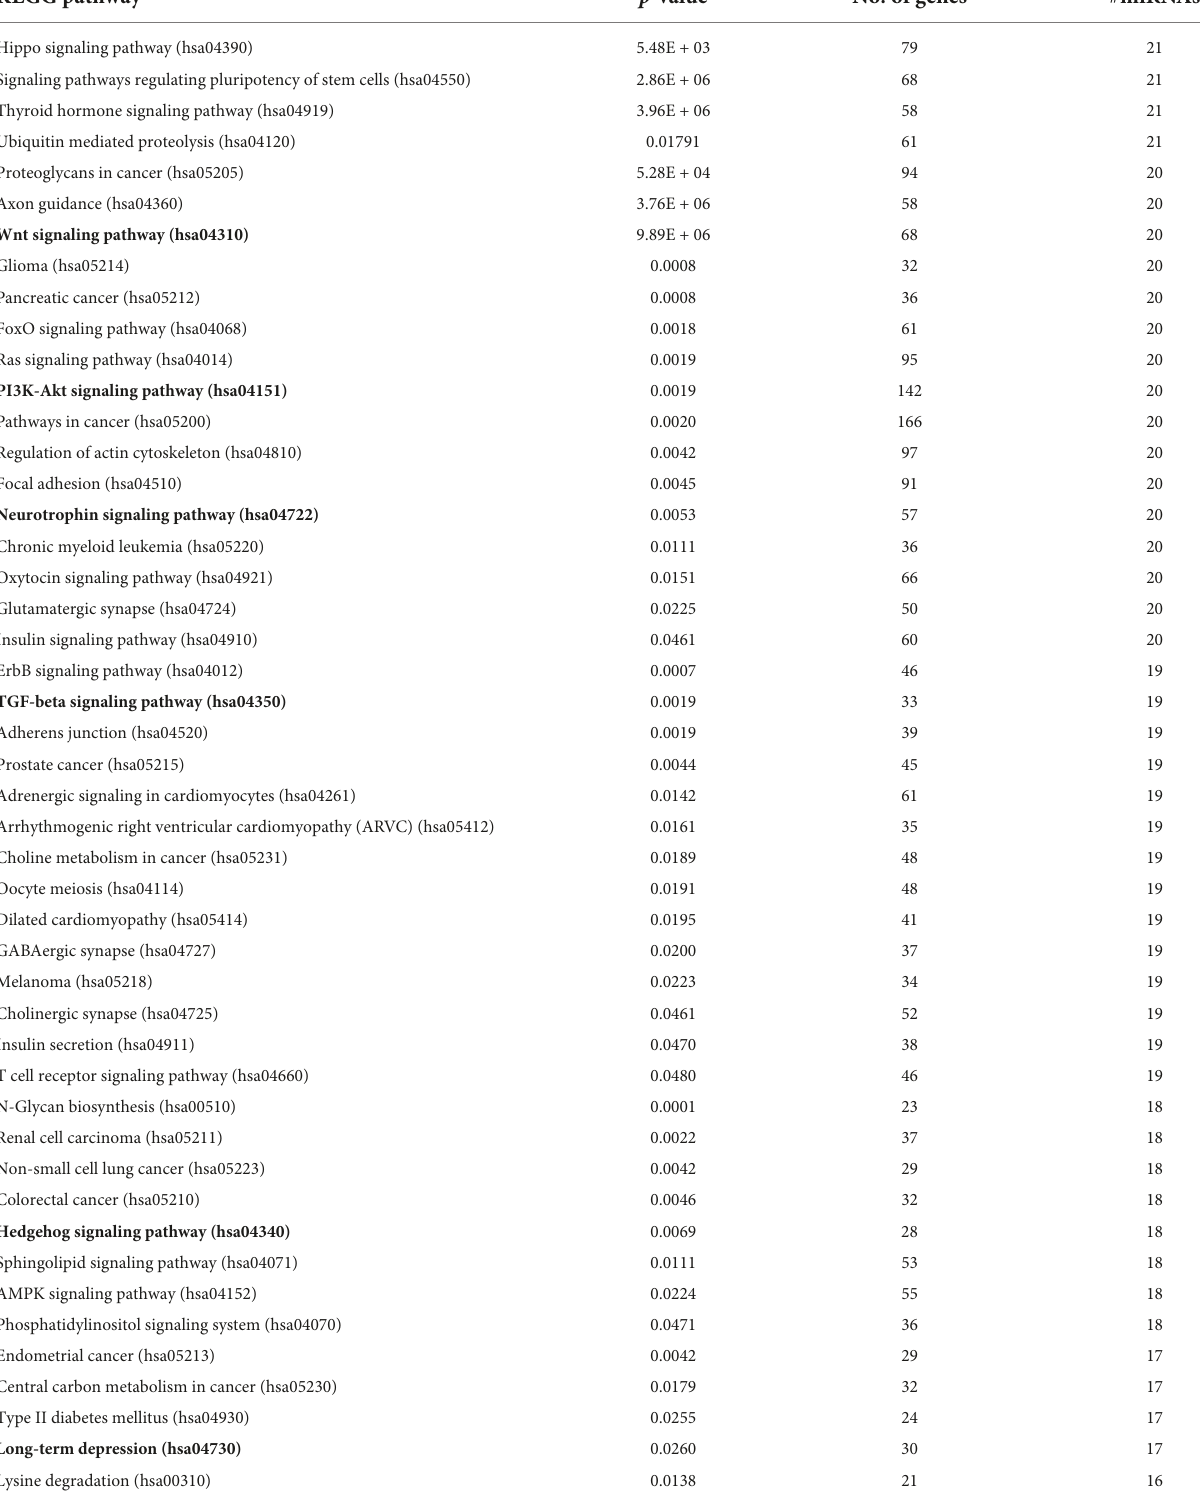
TABLE 4 Kegg pathway of 21 upregulated